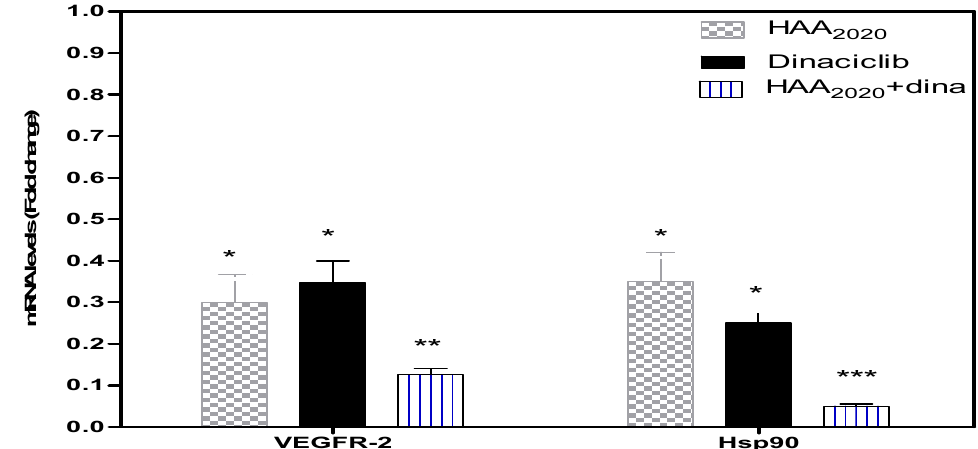
Figure 8. The expression of VEGFR-2 and Hsp90 genes in MCF7 cells. MCF7 cells were treated for 24